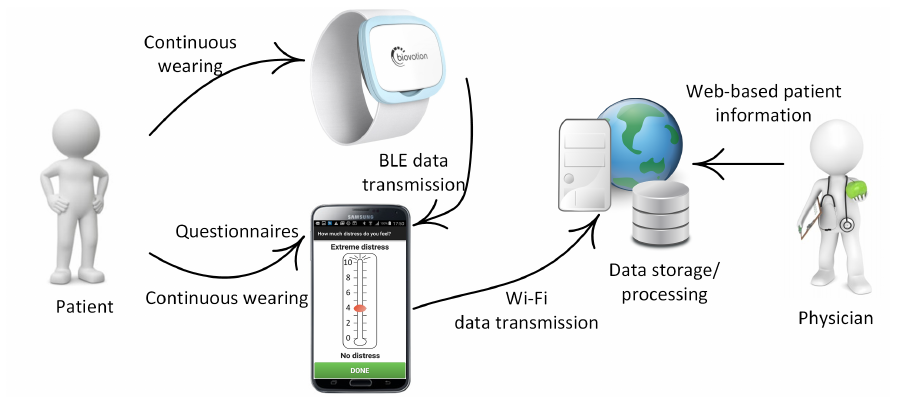
Figure 1. System Overview: body-worn, non-obtrusive sensors, regular encrypted data upload to a secured server, secured web interface for data